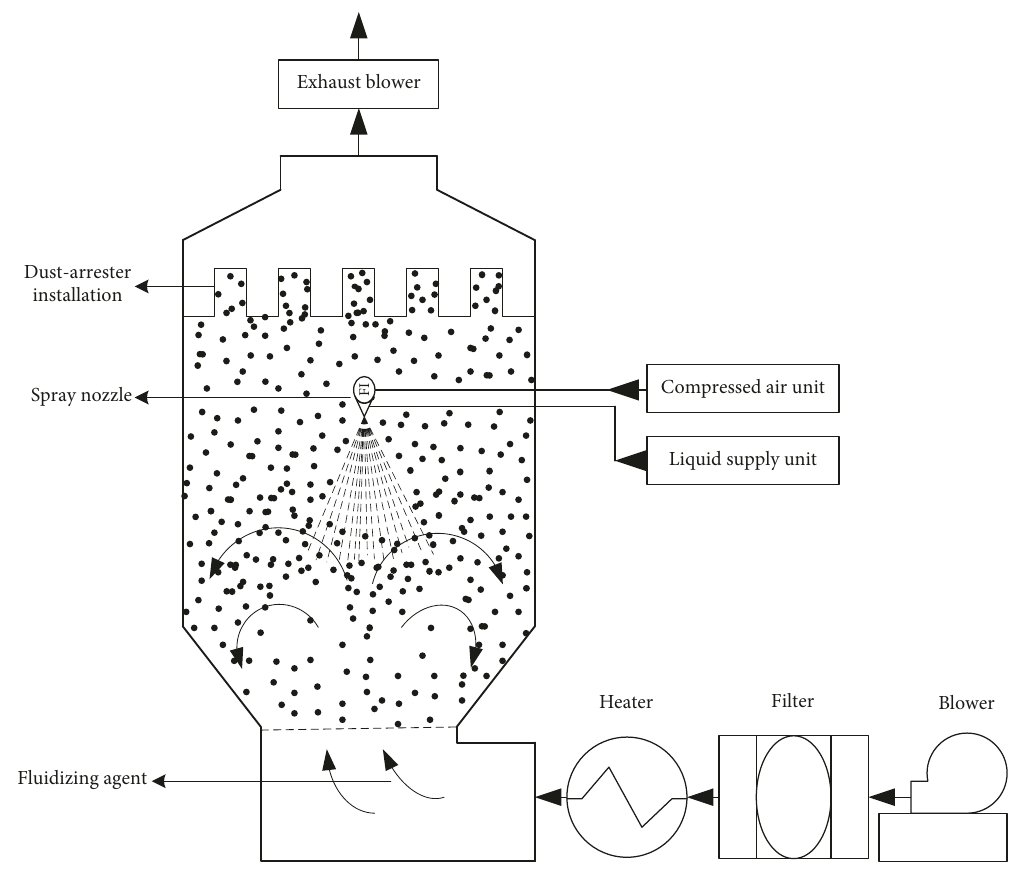
Figure 1: The schematic diagram of